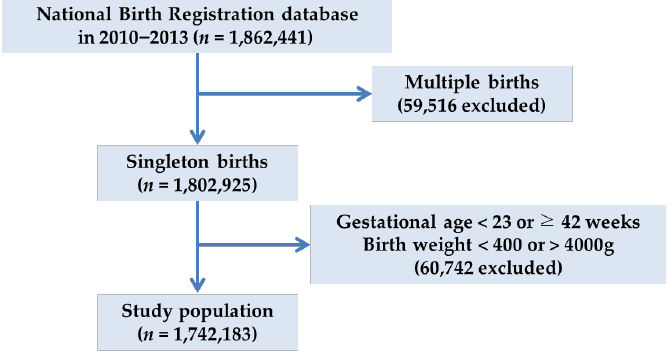
Figure 1. Flow diagram of the study population.